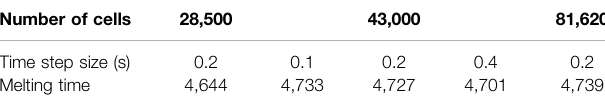
TABLE 3 | The effect of cell number and time step size on the melting time. Number of cells